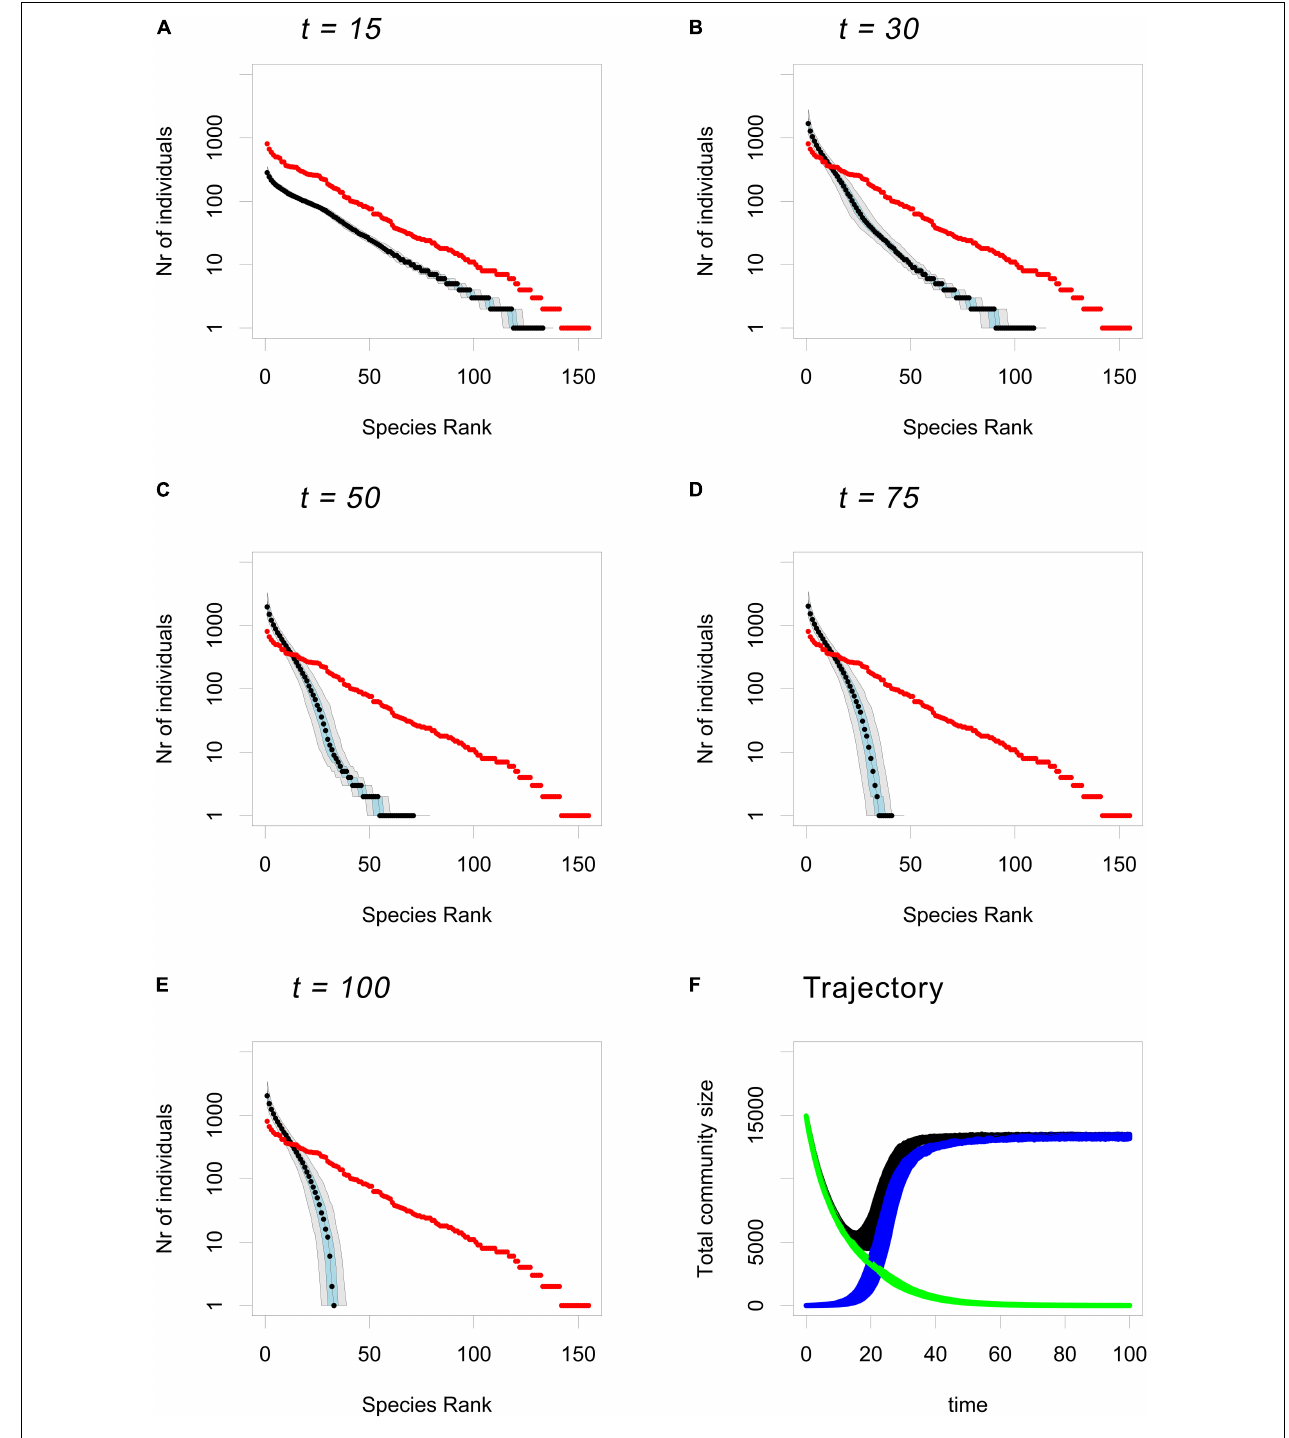
FIGURE 2 | Time trajectory of the RAC under the CWR model. Plots based on 500 CWR simulations using the (default) parameters b 0 , res = 0.05, b 0 , mut = 0.6, d = 0.1, K = 16000 and µ = 0.0005. (A–E) Show the RAC of the community at t = 15 , t = 30, t = 50 , t = 75, and t = 100 respectively, were the median is shown in black, the 25th and the 75th percentile are shown in blue and the 5th and the 95th percentile are shown in gray, and the input community is plotted in red. (F) Shows the trajectories of the total community size (black), the total number of residents in the communities (green) and the total number of mutants in the community (blue).